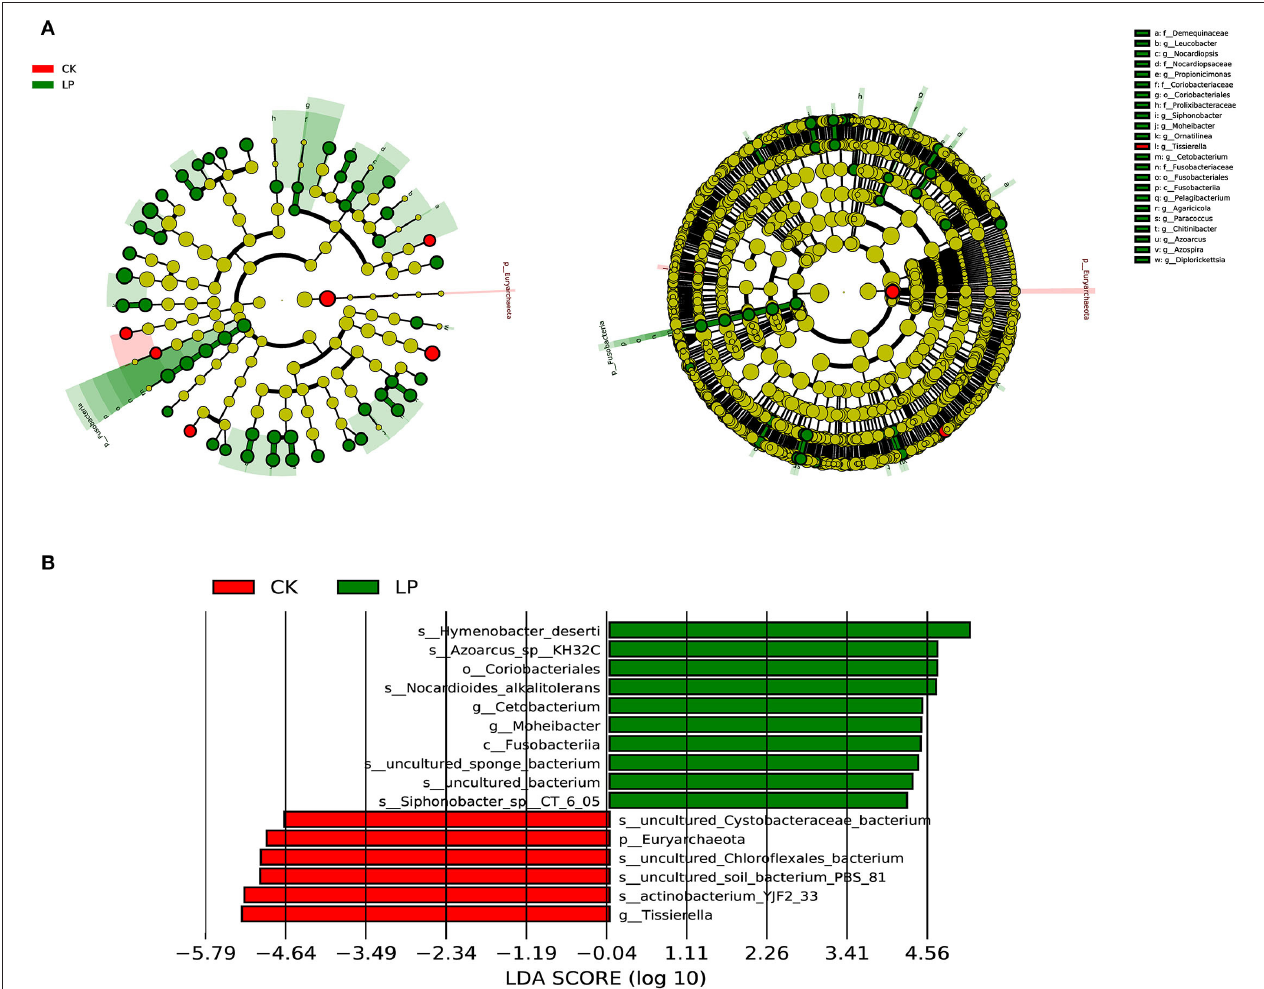
FIGURE 3 | Taxa with different abundances according to linear discriminant analysis (LDA) effect size (LEfSe) analysis in the intercropping and CK groups. (A) Cladogram generated by LEfSe. Statistically significant differences (LDA scores > 2) in absolute abundance of top 50 taxa with the minimum P -value between the intercropping and CK groups, p ≤ 0.05. Red and green nodes indicate enriched taxa in the intercropping and CK groups, respectively. The diameter of each node shows the absolute abundance of each taxon and is proportional to the observed effect size. The circle of evolutionary branching maps from internal to external radiation represents the classification level from the phyla to the species, and notes of species markers in each layer represent the classification level from the phyla to the species from the outside in. (B) Histogram of the LDA scores ( > 2) computed for the top 10 taxa with minimum P -value. Red and green bars indicate enriched taxa in the intercropping and CK groups,